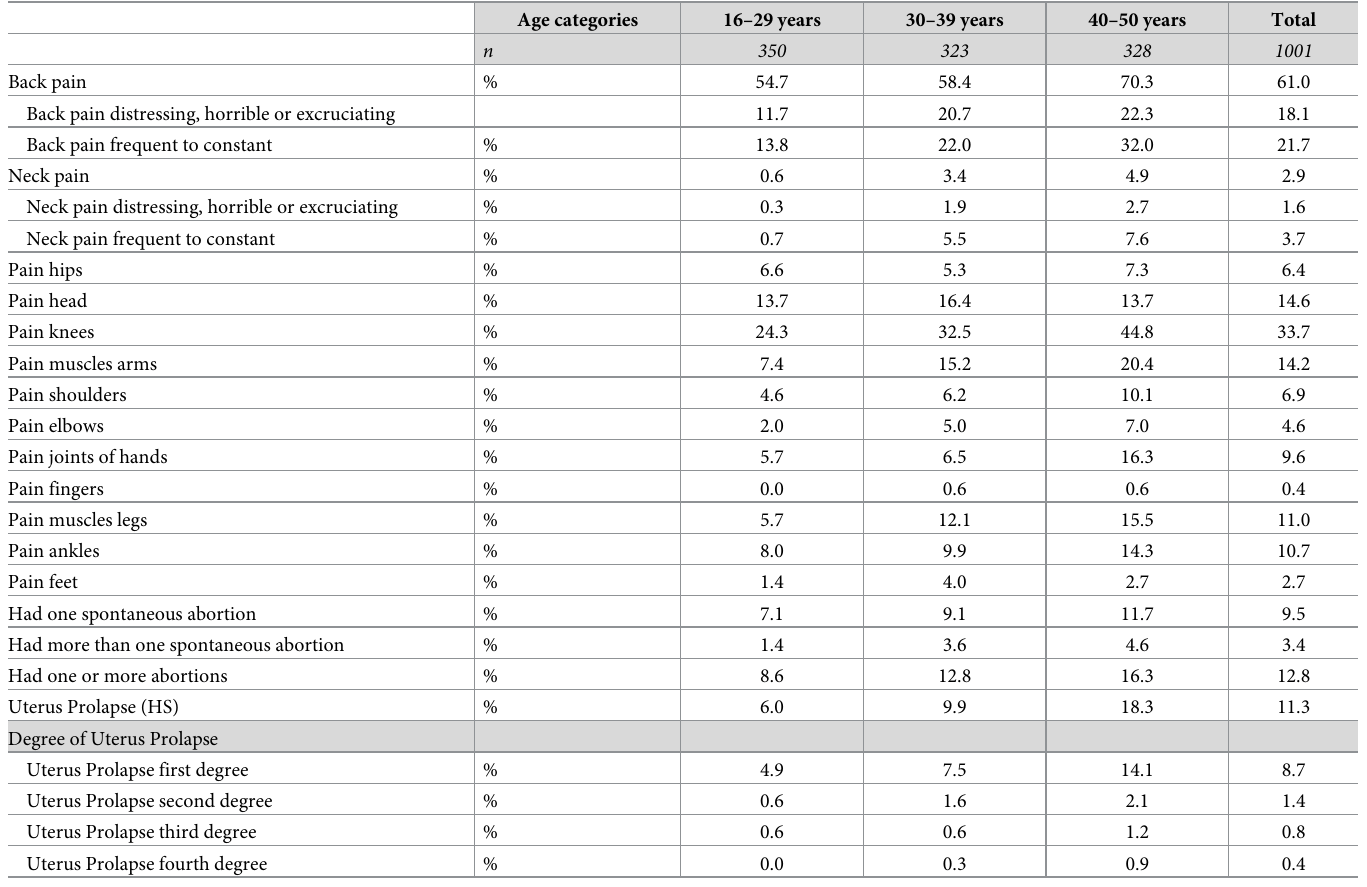
Table 1. Prevalence of women’s self-reported health